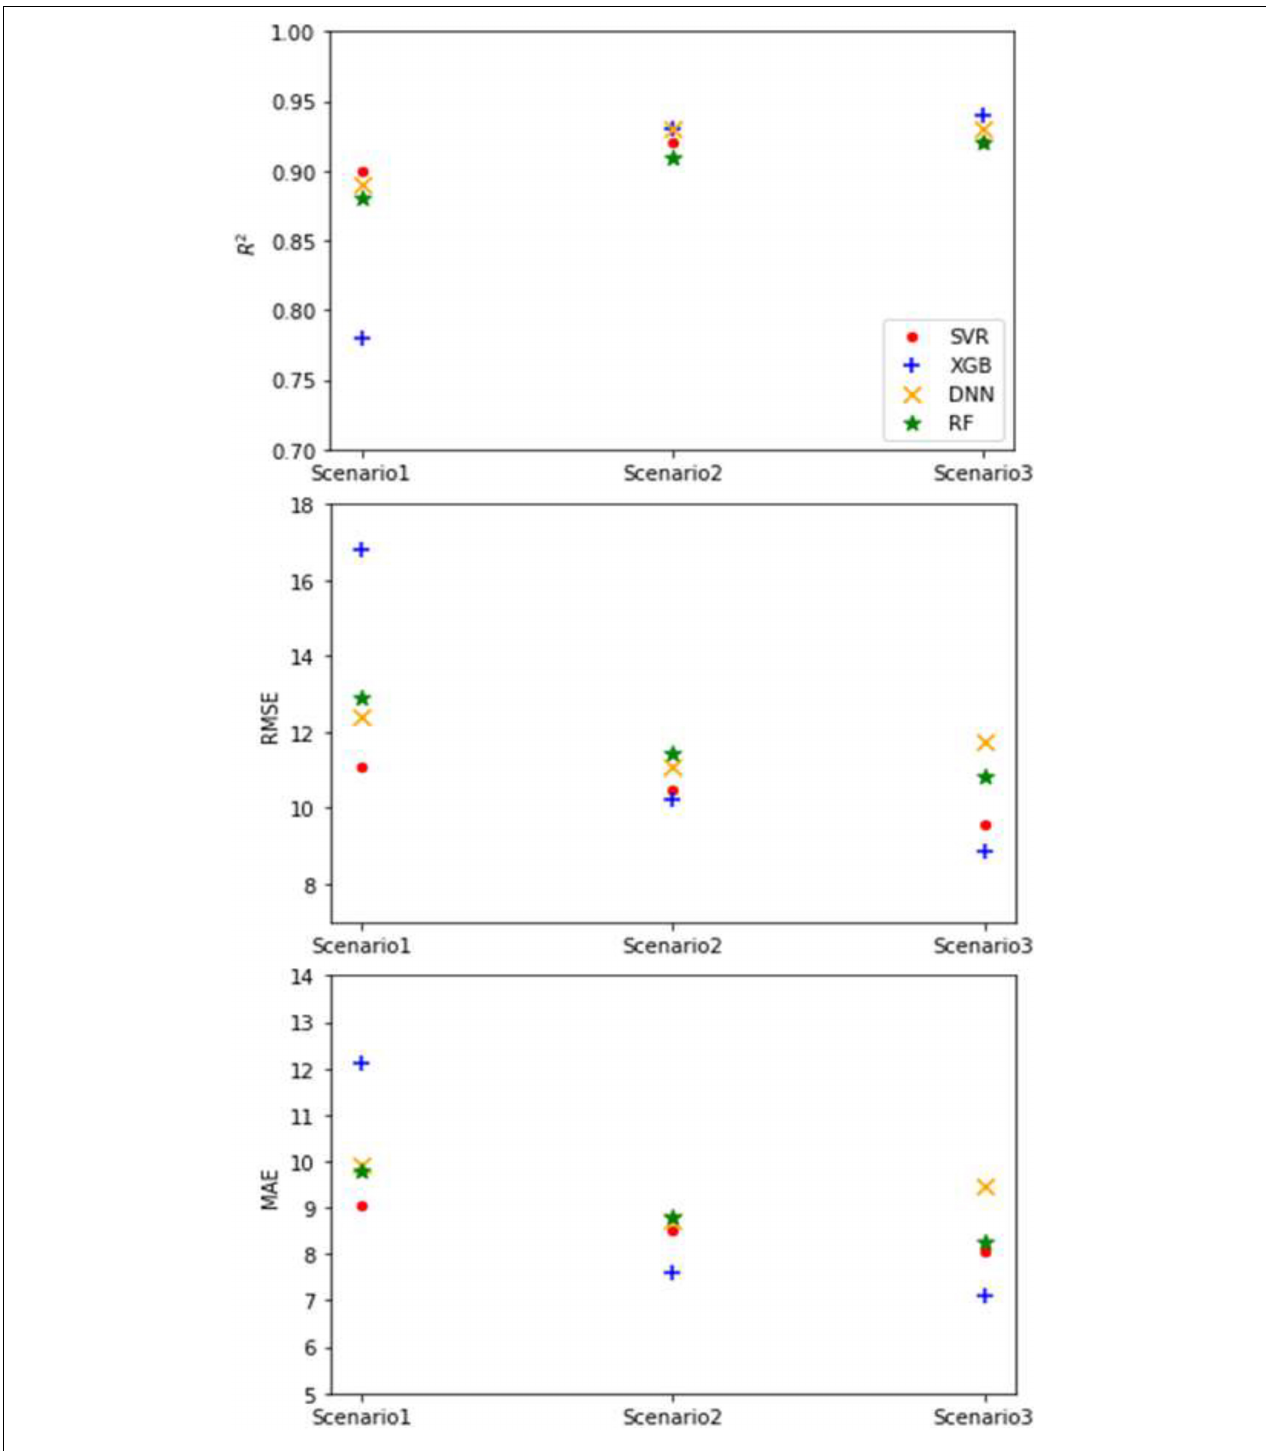
FIGURE 3 | The performance statistics values for different model scenarios.